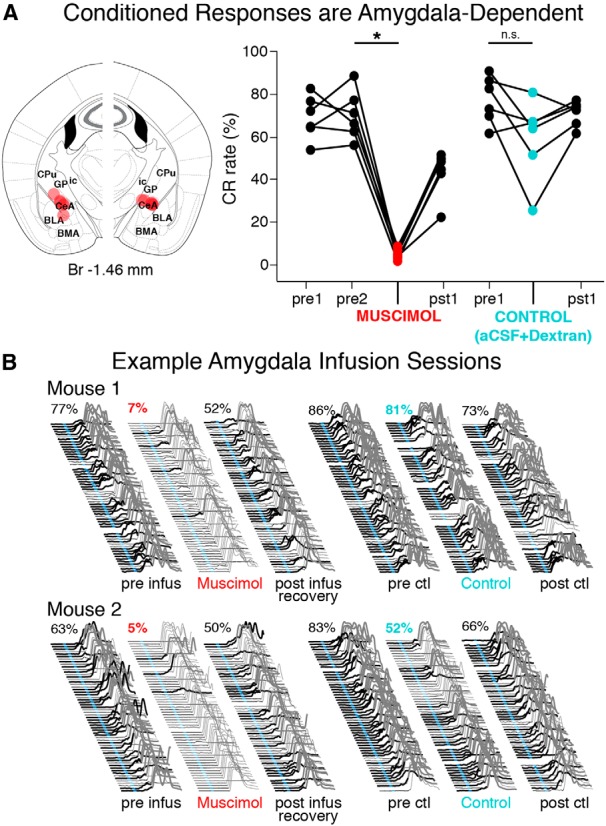
Trace 50-250 CRs were amygdala-dependent in mice, with no residual CR components. A, Bilateral infusions of muscimol (1mm, 100–150 nl) were used to inactivate the anterior central nuclei of the amygdala in 6 trained mice (left). The expression of CRs were nearly abolished (2–9% CR rates) during infusion sessions in all 6 mice (right graph, red markers; paired t = 14.27, df = 5, p < 0.001), whereas the CR rates observed during control infusions were not different than preinfusion sessions (cyan markers; t = 2.34, p = 0.07). B, Example behavior from muscimol (denoted by red text) and control sessions (cyan text) for two mice. Note the significant decrease in the expression of CRs during muscimol infusion sessions, while behavior during control sessions was less globally affected by the infusion procedure. Br, Bregma; CeA, central nucleus of the amygdala; BLA and BMA, basolateral and basomedial nuclei of the amygdala, respectively; CPu, caudate putamen; GP, globus pallidus; ic, internal capsule.